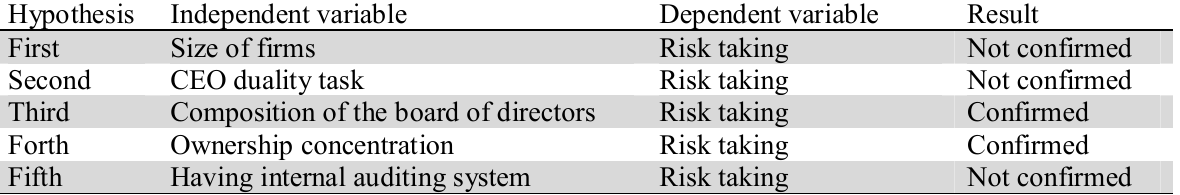
The summary of testing the effects of various factors on risk taking Hypothesis Independent variable Dependent variable